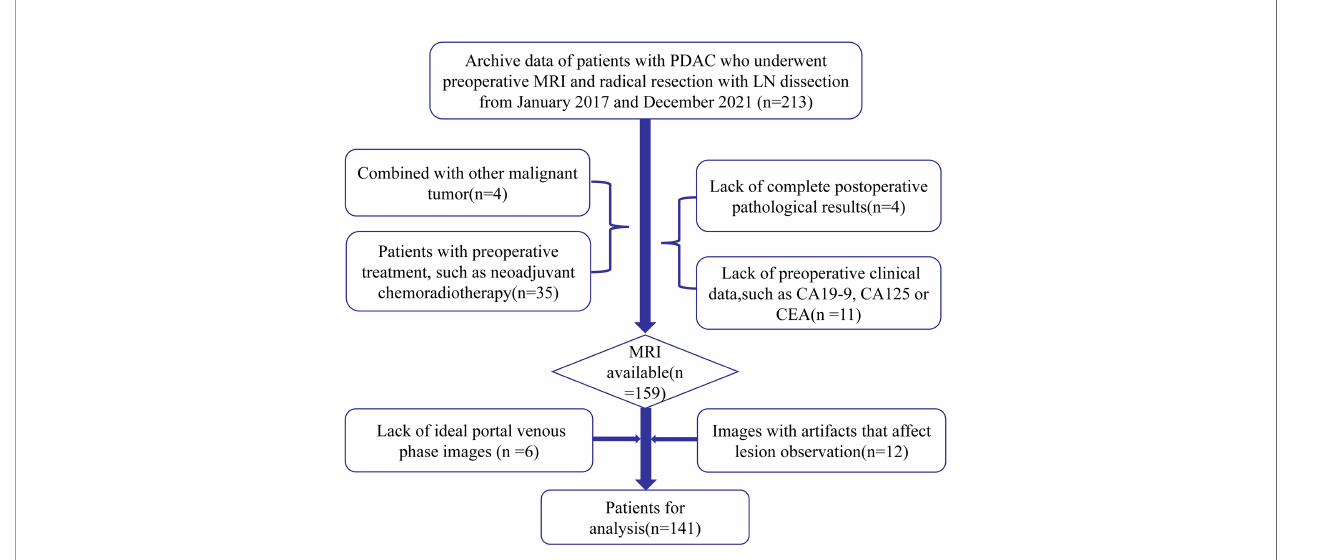
FIGURE 1 | Patient selection fl